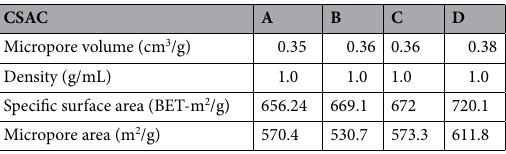
Table 3. Characteristics of the CSAC used for immobilization carrier.